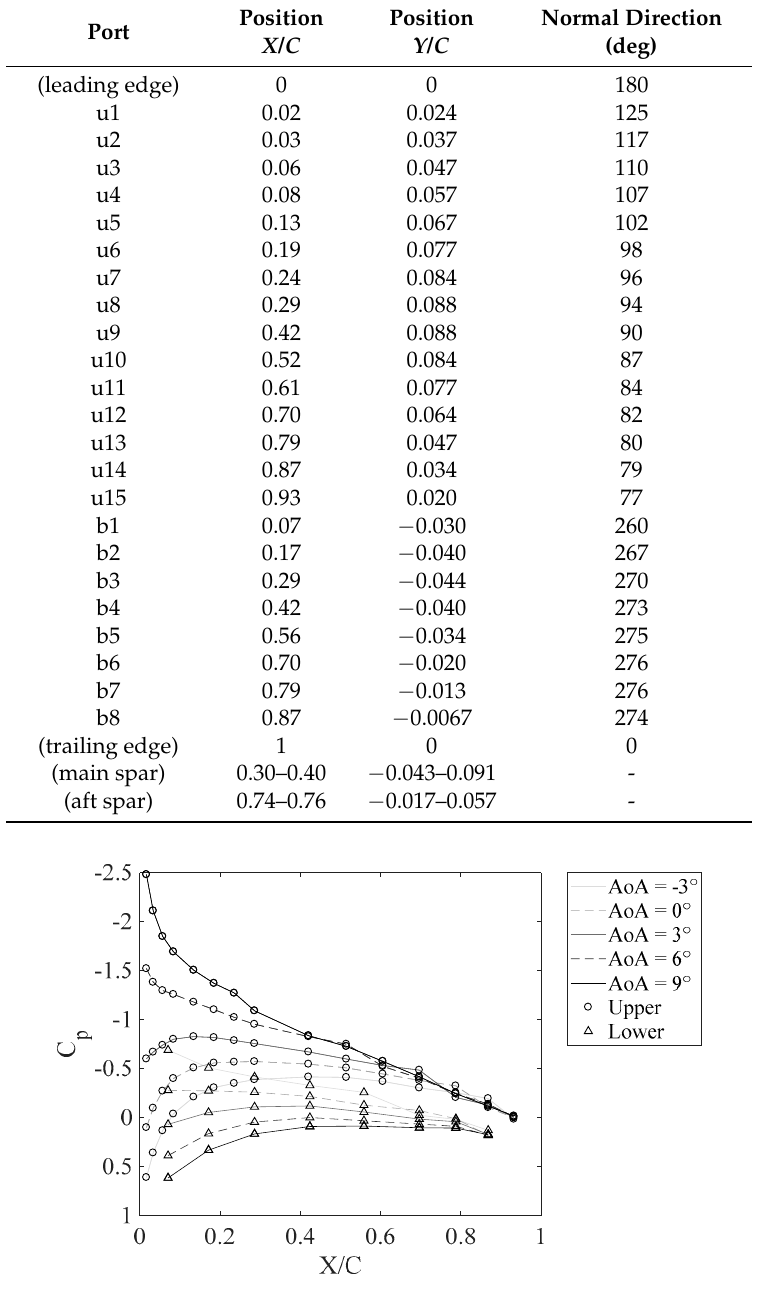
Table 2. Pressure port geometry. C represents chord length.